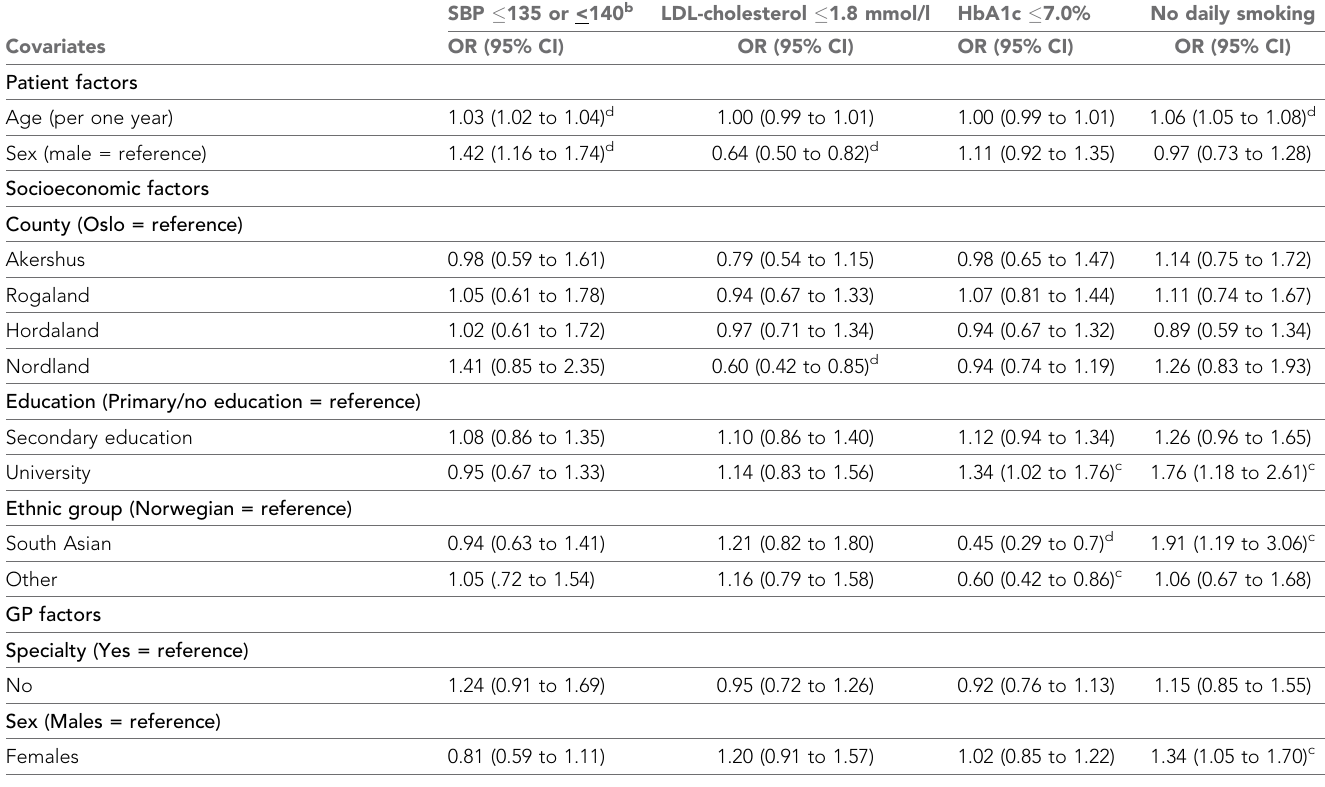
a Multilevel binary logistic regression analyses with four dependent variables in 2260 T2DM patients with CHD, adjusted for clustering between practices. b Systolic blood pressure targets: <140 mmHg for patients not using antihypertensives, and <135 mmHg when medication is prescribed. c P <0.05. d P <0.001. CI = confidence intervals. CHD = coronary heart disease. LDL = low-density lipoprotein. OR = odds ratio. SBP = systolic blood pressure. T2DM = type 2 diabetes